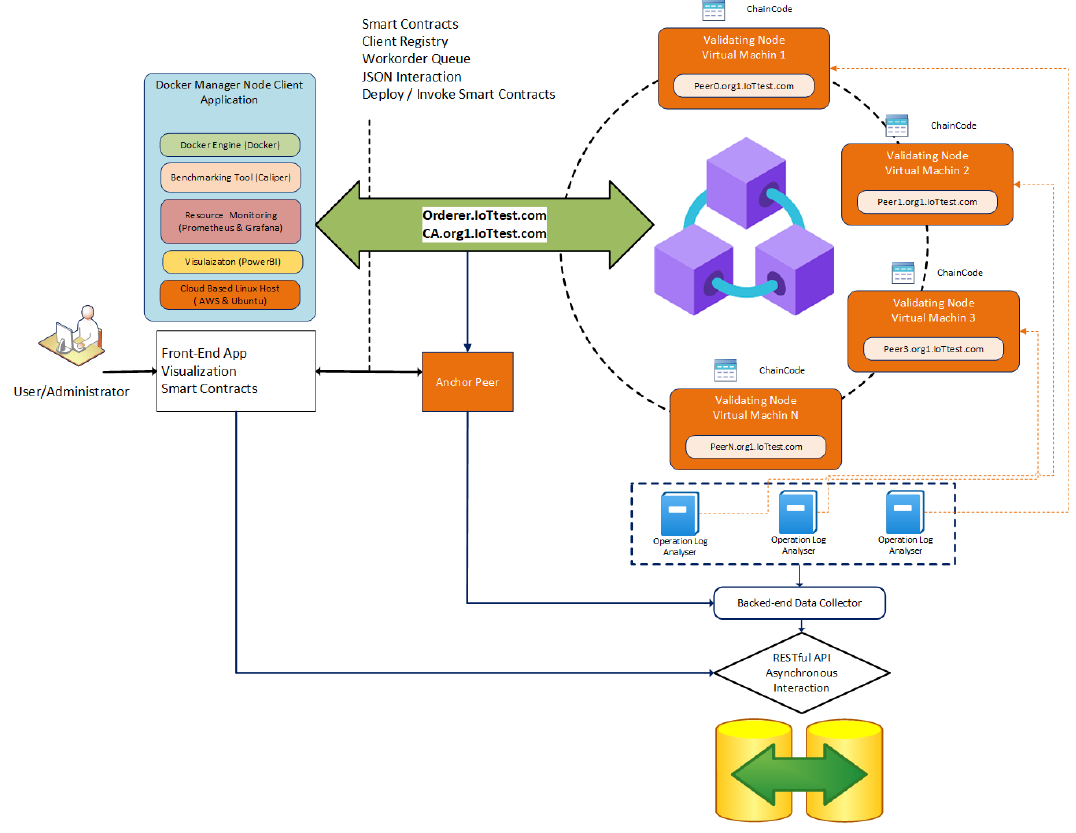
Figure 4. Experimental setup and components for performance